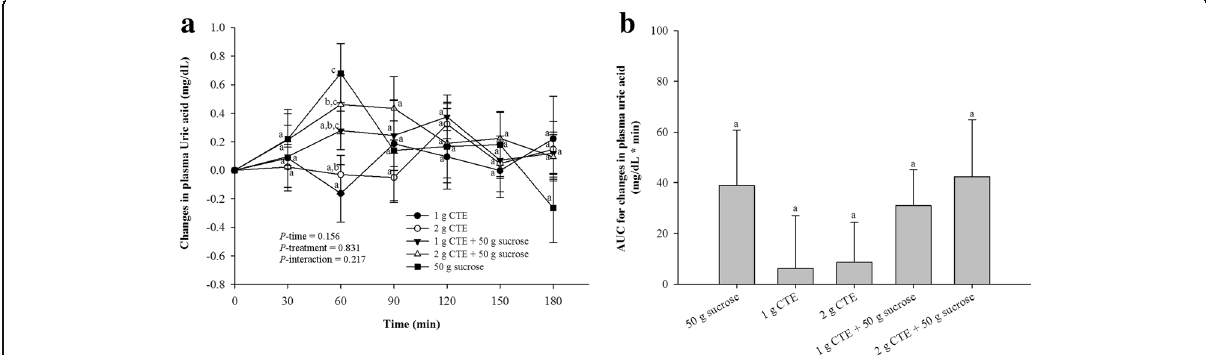
Fig. 4 Postprandial plasma uric acid of five different beverages. a Changes in uric acid concentrations during 180 min of five different beverages; ( b ) Uric acid changes area under the curves (AUCs) of five different beverages. Values are means ± SEM, n = 15. Different letters are significantly different ( P <